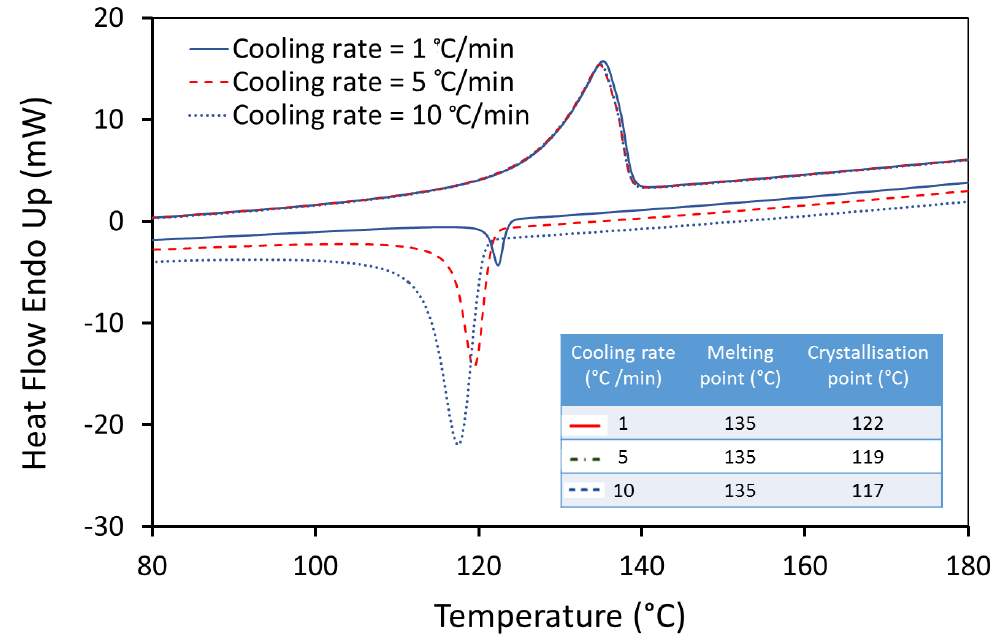
Figure 7. DSC curves of UHMWPE at different cooling rate. The same sample was heated from 25 °C to 220 °C at 10/min.